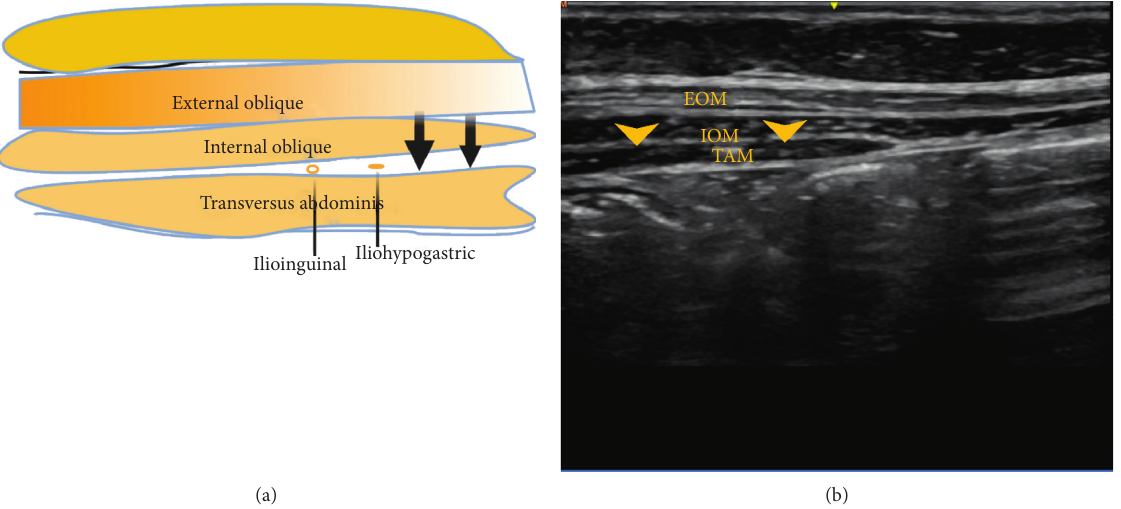
Figure 7: EOM: external oblique muscle; IOM: internal oblique muscle; TAM: transversus abdominis muscle. Black and yellow arrows indicate the point of local anaesthetic infiltration. The yellow dots indicate ilioinguinal and iliohypogastric nerves.